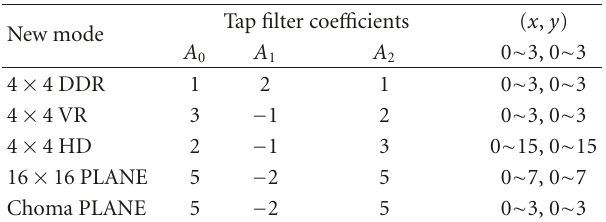
Figure 3: The tap filter of recursive prediction. Table 1: The tap filters corresponding to the five-modified prediction modes.